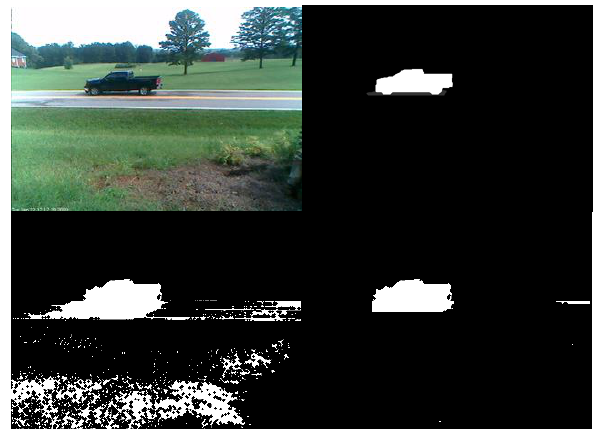
Figure 6. Experimental results for video Roadside. Top row: left – current frame, right – ground truth. Bottom row: left – original algorithm, right – our modified